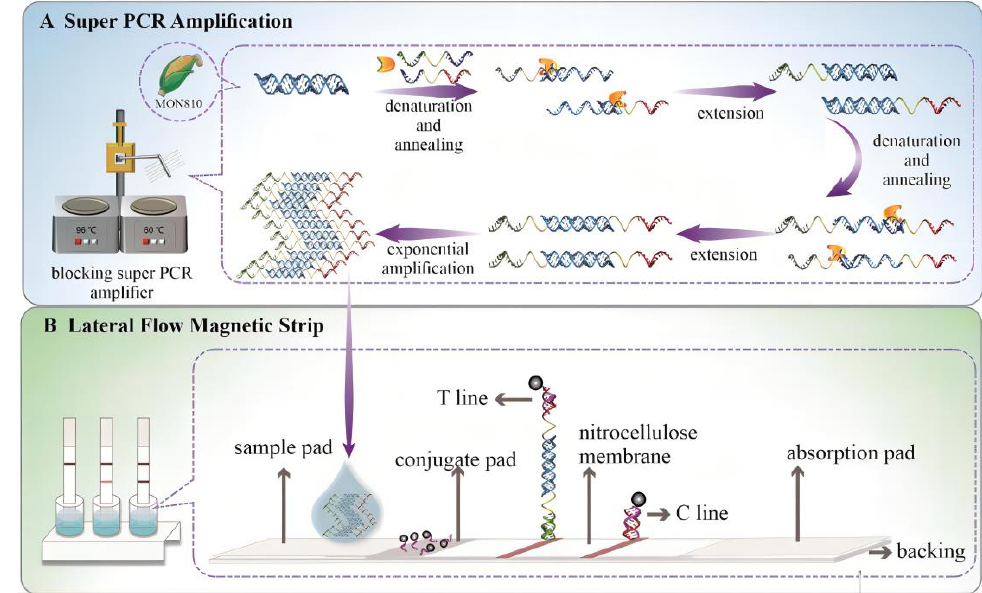
Figure 2. An ultra-fast and extremely stable magnetic test strip based on BS-PCR for the rapid detection of transgenic maize MON810 [17]. The principle of Super PCR amplification ( A ); Structure and composition of the magnetic strip ( B ).